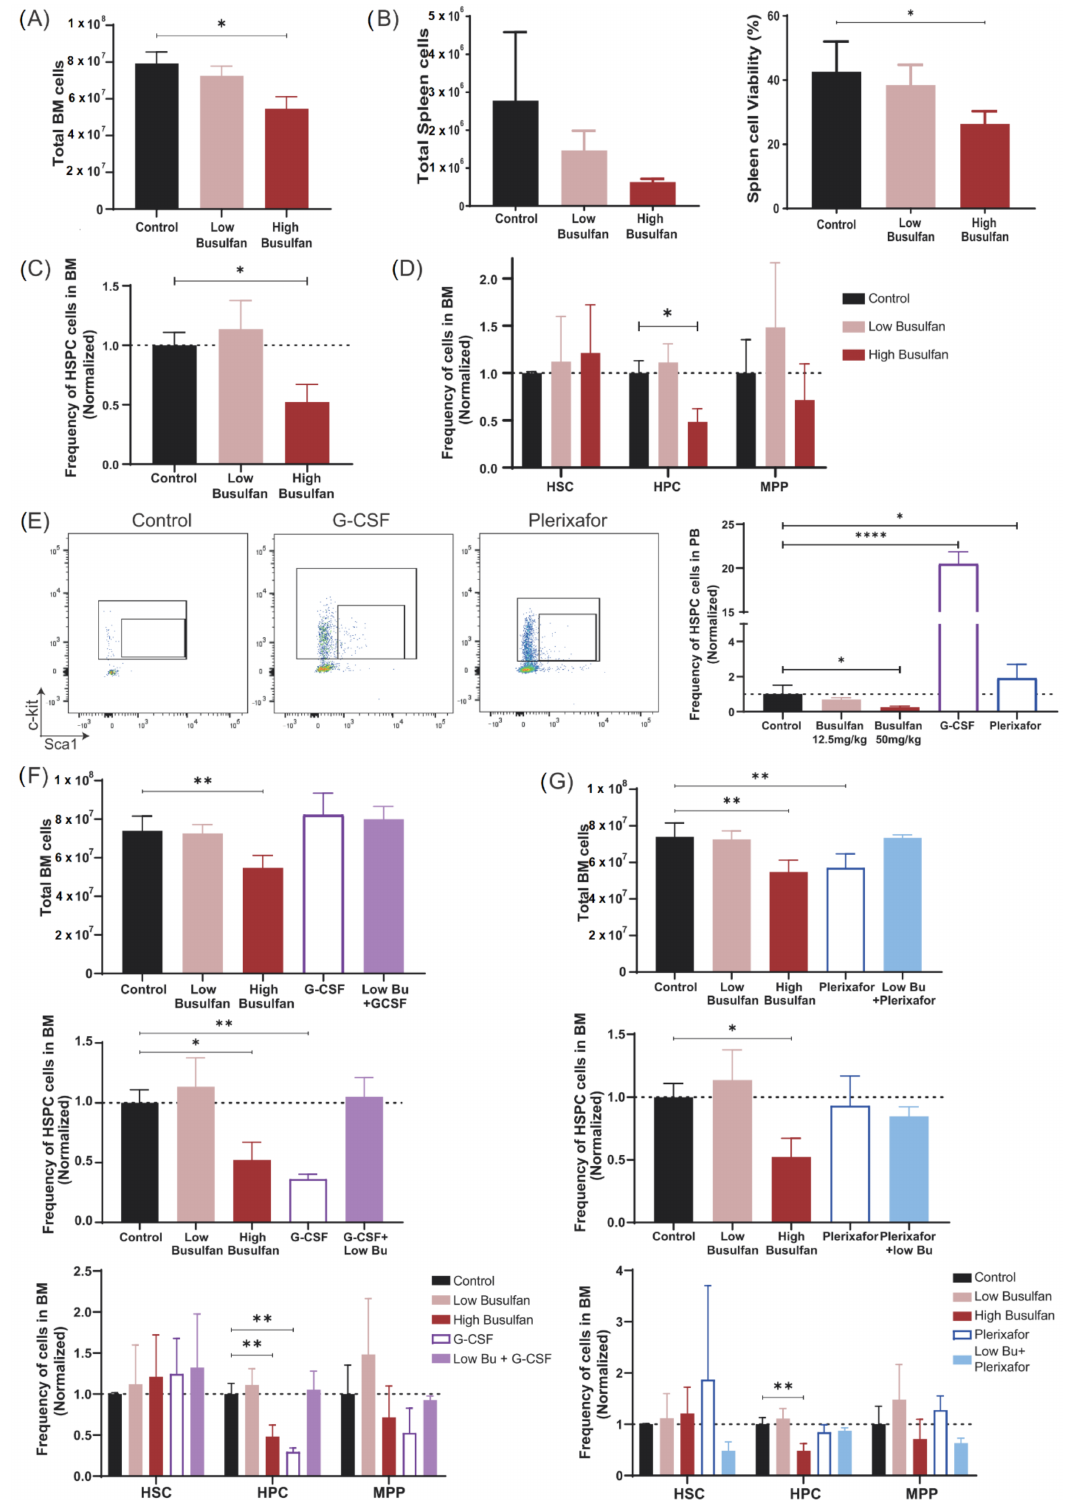
Figure 3. Effect of busulfan and mobilizing agents on BM HSCs. ( A ) Total BM cell numbers, 24 h after busulfan conditioning (low and high dose) compared to the control group (without busulfan). (One-way ANOVA, * p < 0.05). ( B ) Total spleen cell numbers and cell viability after busulfan conditioning (24 h after). (One-way ANOVA; * p < 0.05). ( C ) Frequency of HSPCs (LSK; Lin-Sca1 + cKit +) cells in BM 24 h after busulfan conditioning, normalized to control mice. (One-way ANOVA; * p <